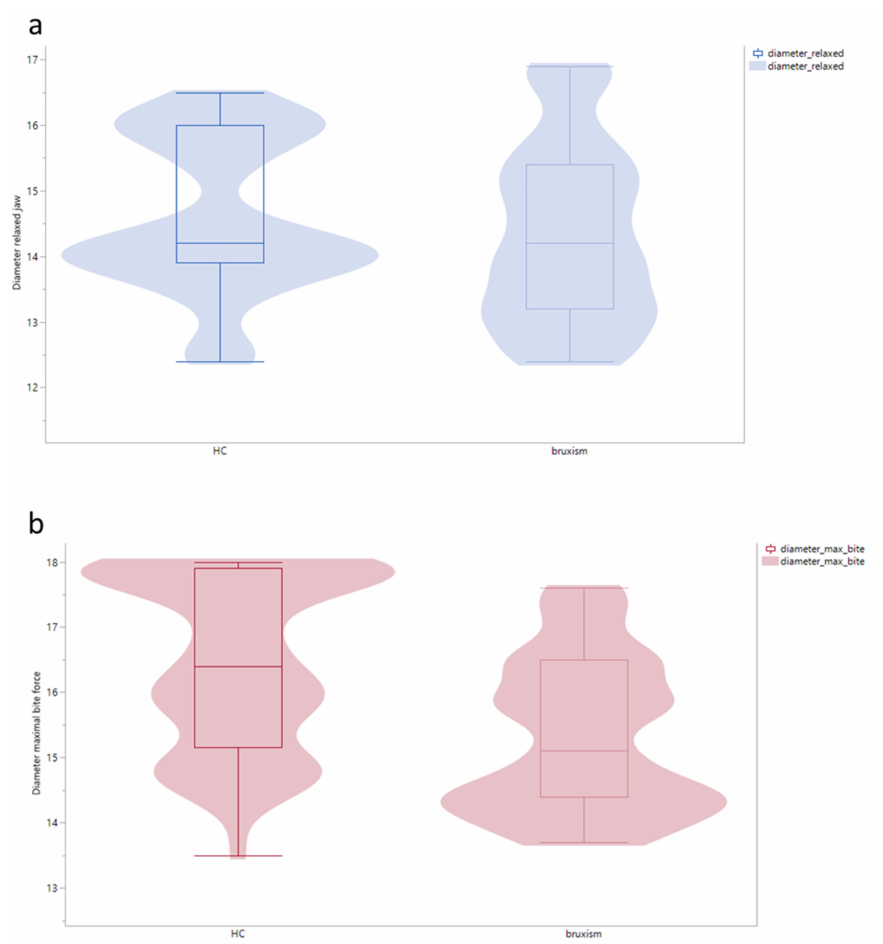
Figure 2. ( a ) Diameter relaxed, and ( b ) diameter with full force bite, of the musculus masseter in HC and bruxism patients ( p <